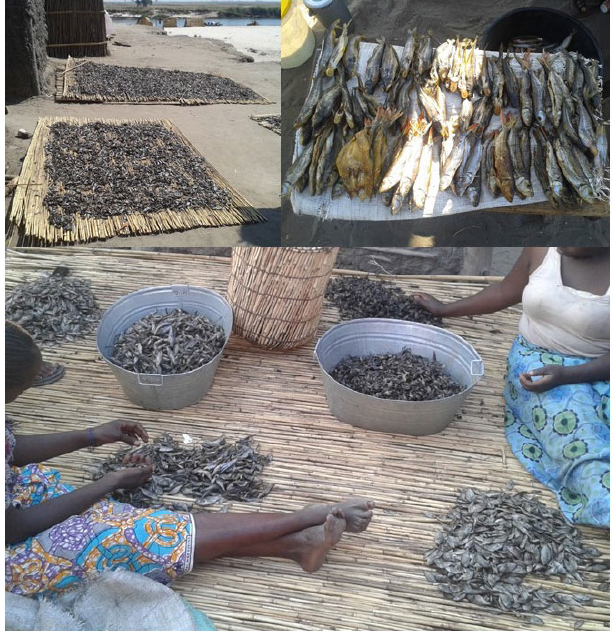
Fig. 2 . Photographs of juveniles of larger fish species caught and dried in the Barotse Floodplain